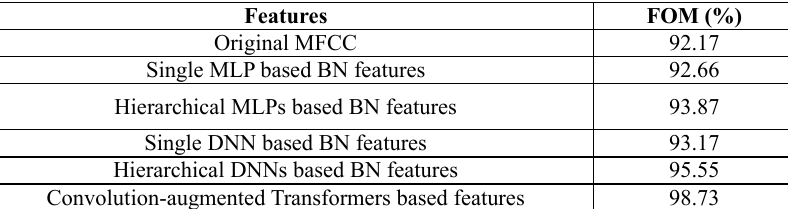
Table 3. Performance Comparison between different